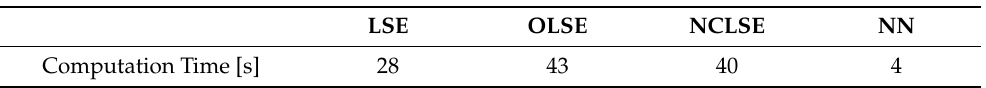
Table 4. Mean computation times [s] to compute a single T2 map of the entire joint. Standard devi- ation was below 1 s for all fitting methods (calculated over 100 repetitions of the fitting process). Abbreviations are defined in Table 1.